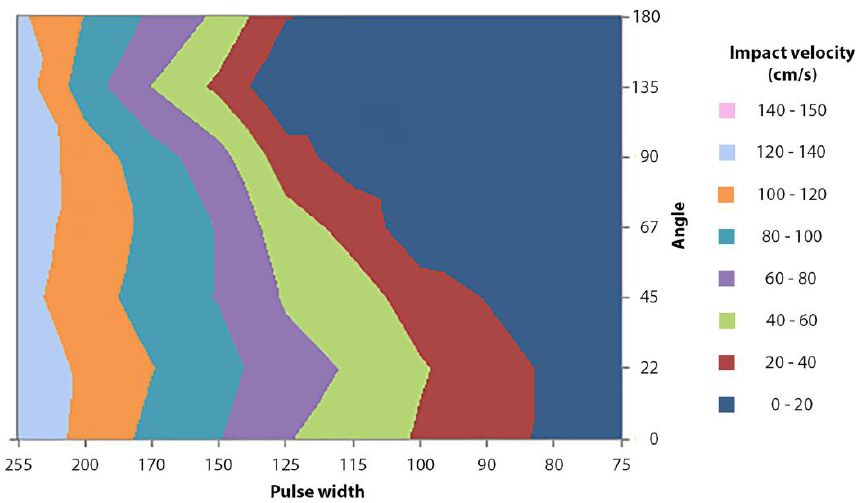
Figure 8. The impact velocity of the microneedle mount (in impact insertion mode) as a function of pulse width (8 bit dimensionless value; 0–255) and angle from the direction of the gravitational force (mean, n = 3, except for 0° which was n = 10).